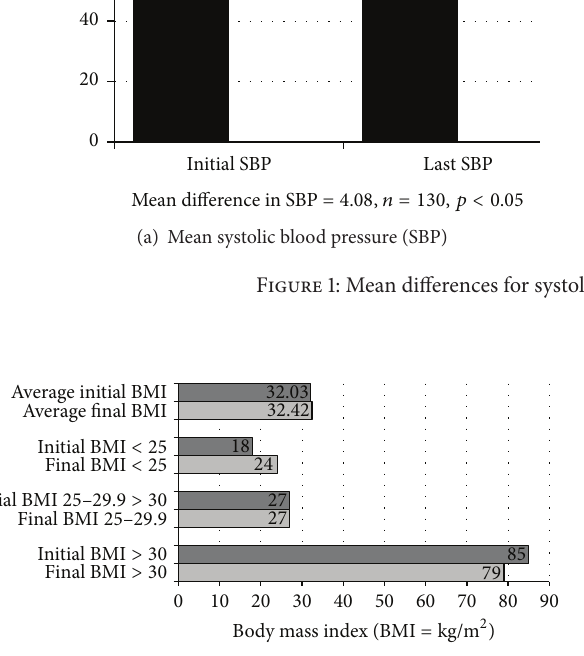
Figure 2: Mean differences in baseline and ending body mass